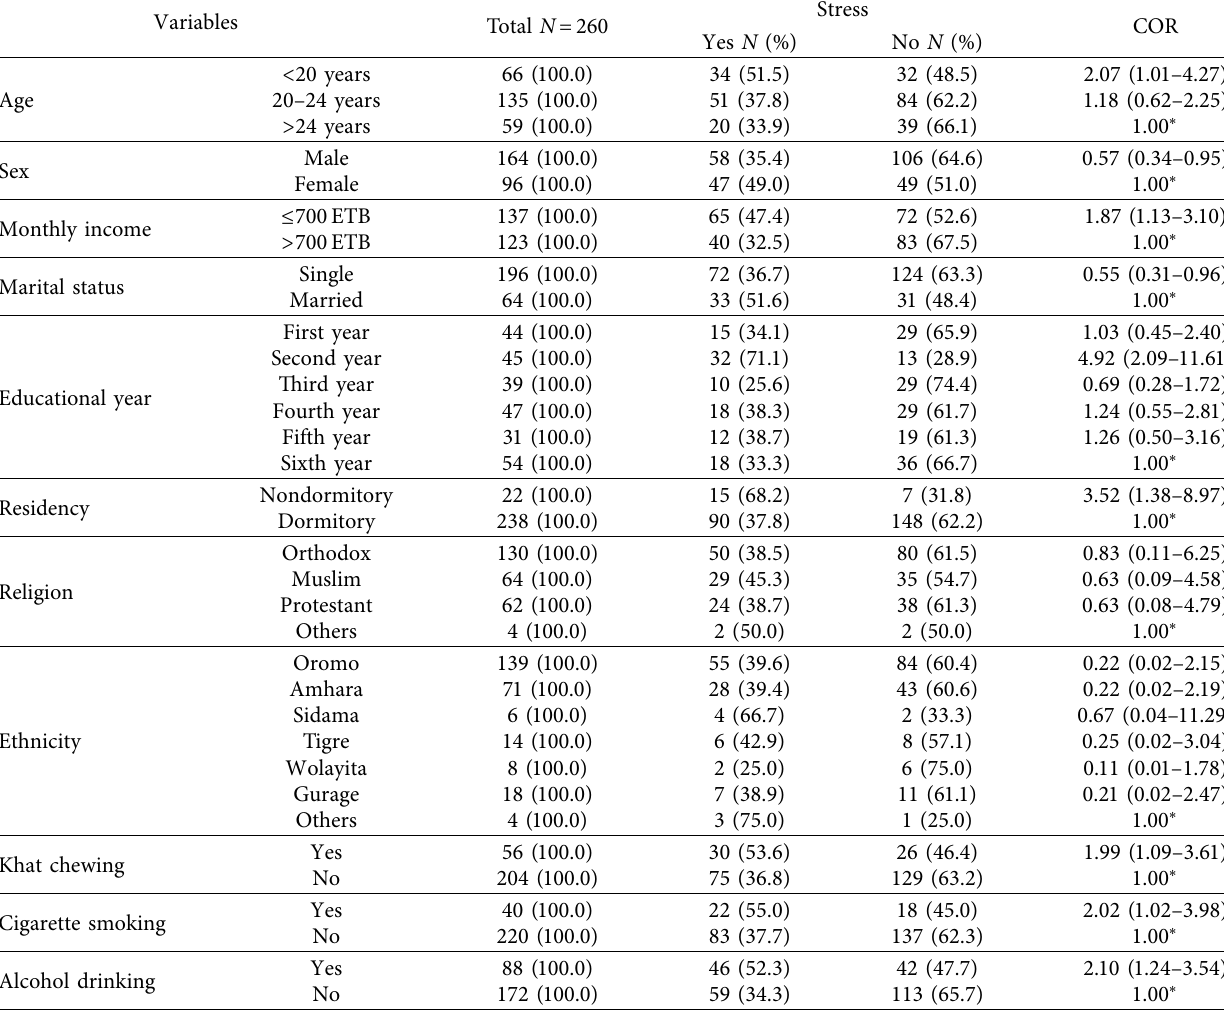
Table 7: Bivariate logistic regression of factors associated with stress, N � 260, AU, January 2019.